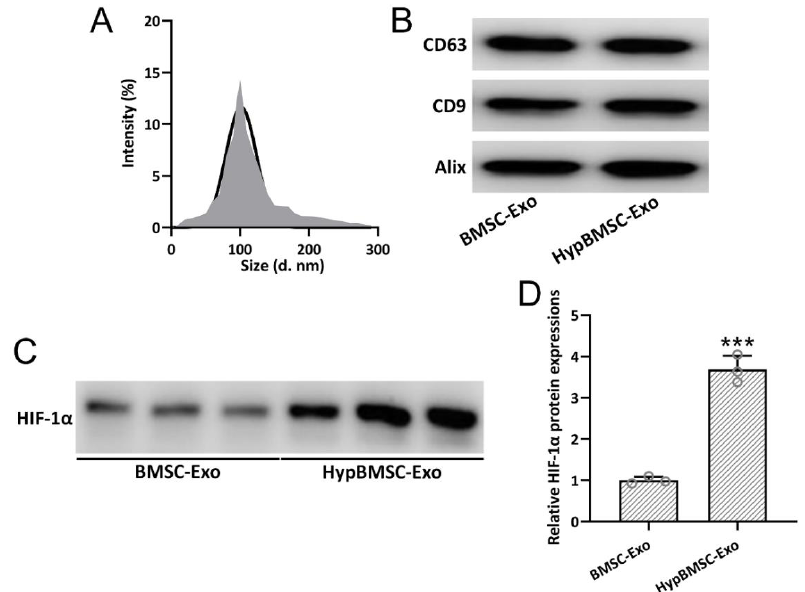
Figure 3. Identification of BMSC-derived exosomes. The size distribution of hypBMSC-Exo and exosomes derived from BMSCs (BMSC-Exo) ( A ). Detection of CD9, CD63, and Alix expression in BMSC-Exo and hypBMSC-Exo by Western blot ( B ). Detection of HIF-1 α expression in BMSC-Exo and hypBMSC-Exo by Western blot ( C , D ). The data are shown with mean ± SD. The experiments were repeated 3 times with pooled lysates from each group. *** p < 0.001 compared to BMSC-Exo. Mann–Whitney test. BMSCs, bone marrow mesenchymal stem cells; HIF-1 α , hypoxia-inducible factor-1 α ; SD, standard